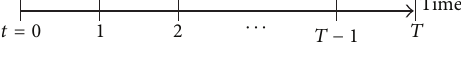
Figure 1: Timing in